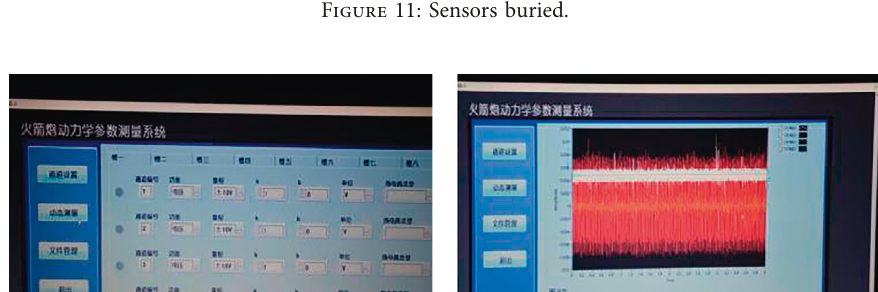
Figure 11: Sensors buried.